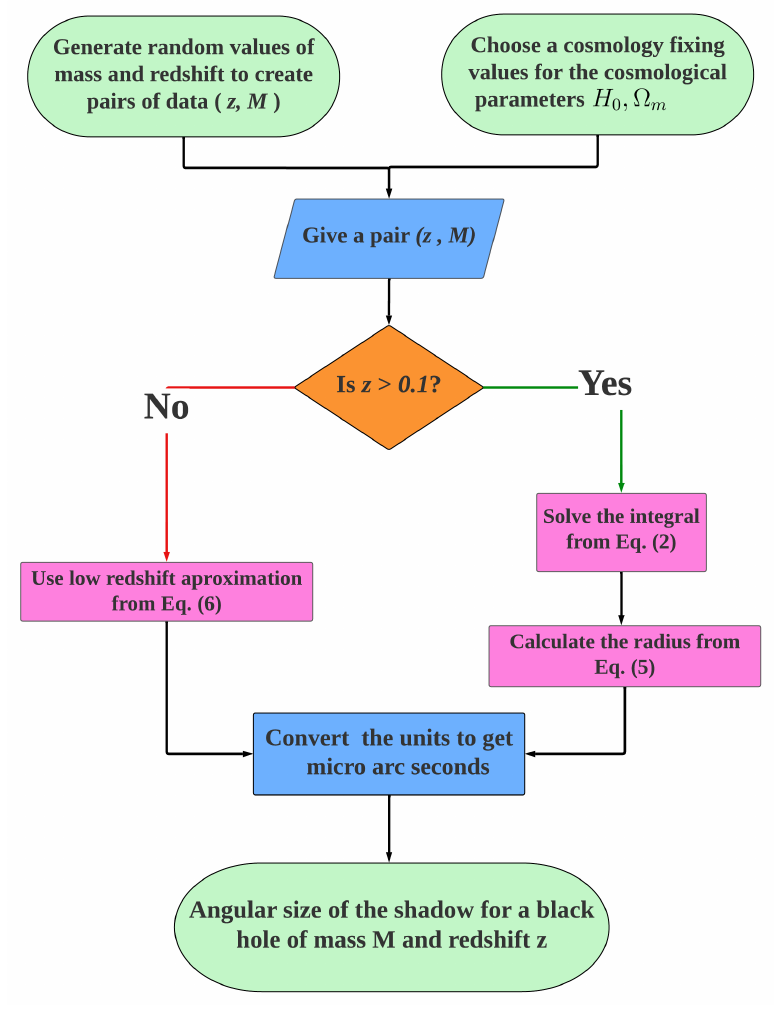
Figure 2. Architecture method to forecast SMBH shadows. The color boxes denote the physical quantities and priors (green color), the setting of variables and units (blue color), the redshift cutoff (orange color) and the computation employed (pink color).